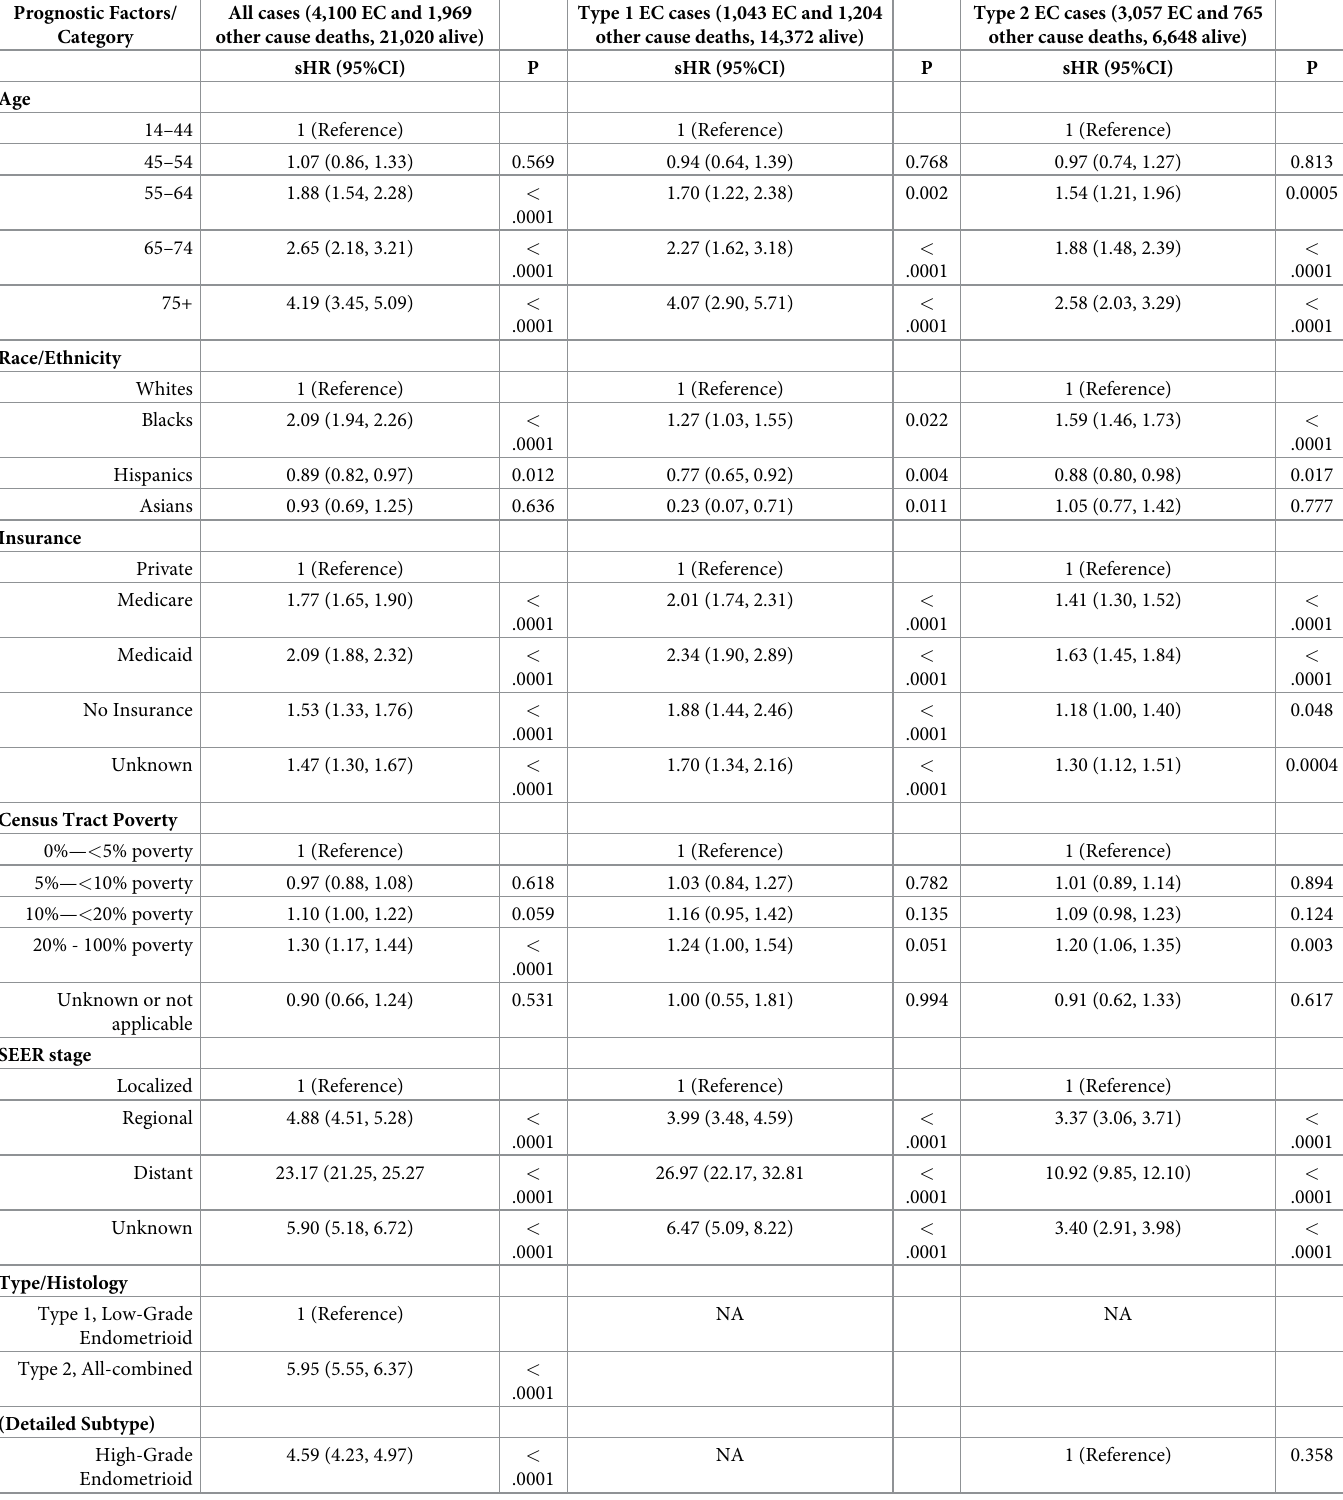
Table 4. Univariable Fine-Gray regression models assessing demographic, social, and clinical predictors of risk of EC death in Florida, 2005–2016. Prognostic Factors/